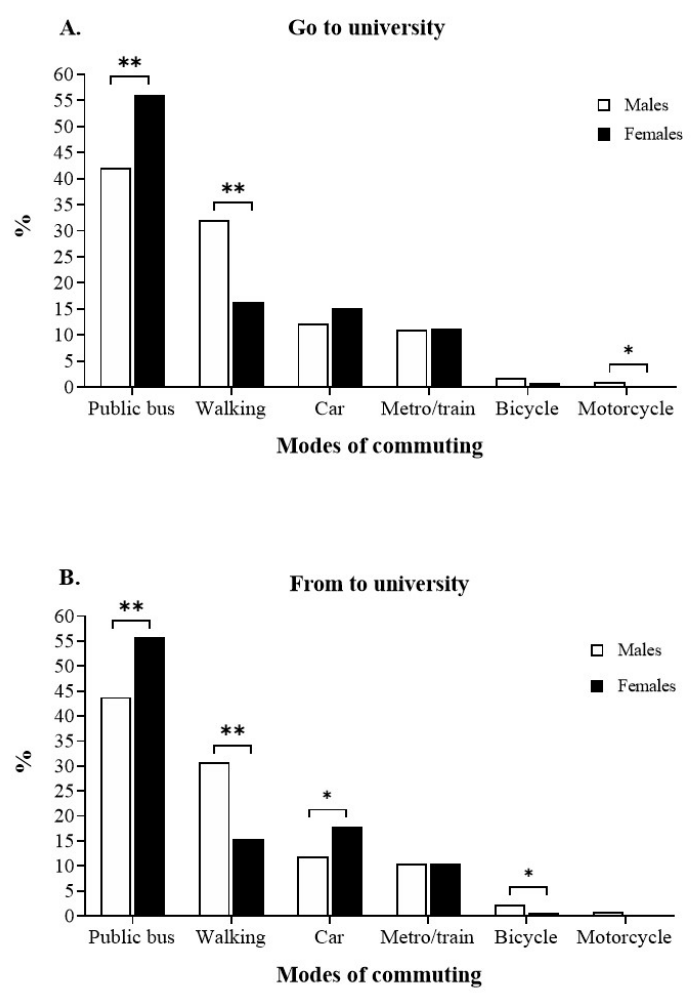
Figure 1. Commuting patterns both ( A ) to university and ( B ) from university in university students by gender. (*) Significant differences with p < 0.05 and (**) significant differences with p < 0.001. Sociodemographic characteristics and commuting behaviors by gender are presented in Table 1. The mean age was 22.4 ± 5.6 years; men were significantly older than women ( p < 0.001), and more men than women lived in a family residence ( p < 0.001). Most of the sample lived in an urban area (96.8%) and had a medium socioeconomic status (52.6%), without statistical differences among genders. A percentage of 71.4% men and 44.9% women came from public universities with geographical area in Valparaíso ( p < 0.001). The commuting time and distance to university were higher in public than private mode of commuting ( p < 0.001). The commuting speed was higher in private mode of commut- ing followed by public and active mode of commuting ( p < 0.001). The commuting energy expenditure per min was higher in active commuters followed by public and private com- muters, and total commuting energy expenditure was higher in public commuters, fol- lowed by active and private commuters in women and men (all, p < 0.001).